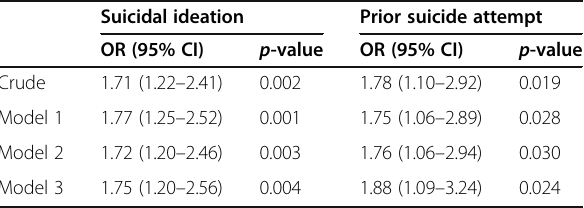
Odds ratios between patients with and without MOH were estimated by using backward stepwise (conditional) logistic regression models. Demographics were controlled in Model 1, including age, gender, education level ( ≤ High school/ ≥ University), marital status (married/unmarried), employment status (unemployed/employed). In addition to demographics, headache profiles and disabilities were also controlled in Model 2, including age at migraine onset, aura status (yes/no), headache frequency, and the presence of at least moderate disability (MIDAS ≥ 11). Model 3 included demographics and headache profiles, as well as depression (HADS-D ≥ 11), anxiety (HADS-A ≥ 11), and poor sleep quality